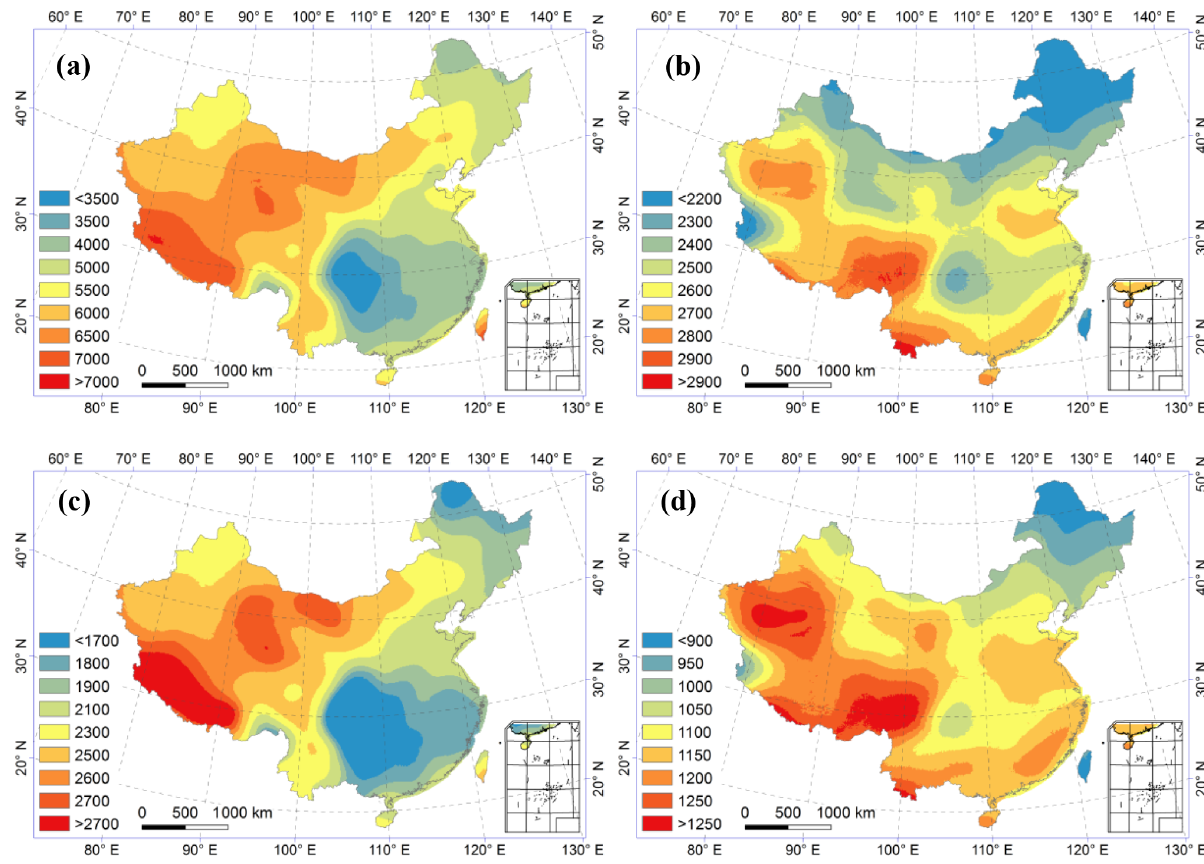
Figure 5. Spatial pattern of global radiation (a) , diffuse radiation (b) , PAR (c) , and diffuse PAR (d) in China for 1981–2010. Units are MJm − 2 yr − 1